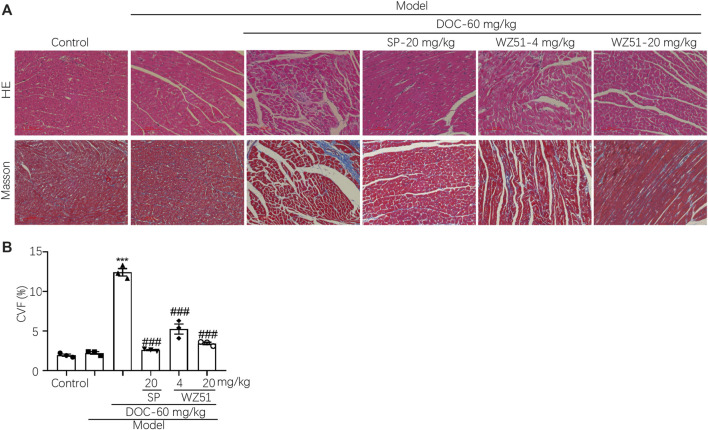
WZ51 attenuated MF in renal hypertensive rats. (A, B) After administration of WZ51 or SP, the heart tissues of each group were collected. Hematoxylin and eosin (HE) and Masson’s staining were performed. Representative images are shown (200 × magnification). (C) Statistical analysis of Masson’s staining (***p < 0.001 vs. CON; ###
P <0.0.001 vs. DOC; n = 0.3). CVF = collagen volume fraction.